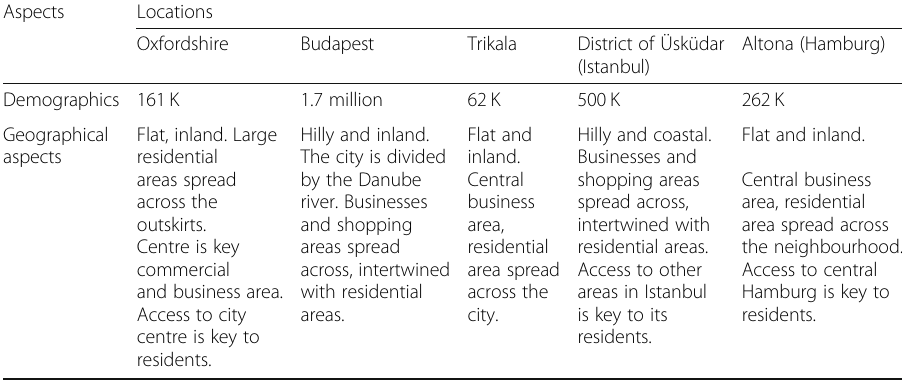
Table 2 Cities-4-People cities average population Aspects